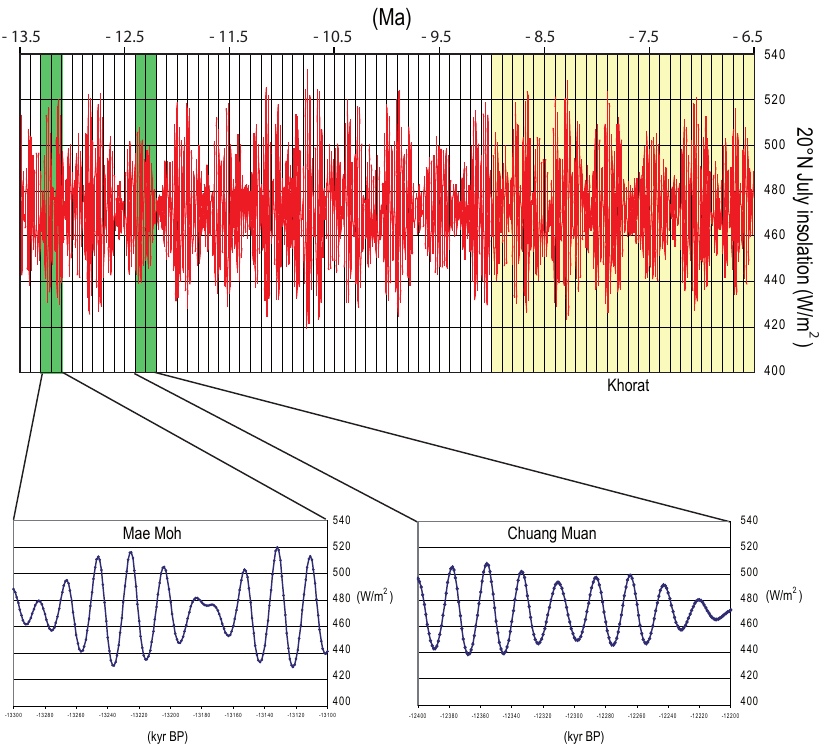
Figure 4. Northern hemisphere summer insolation computed at 20°N, between 13.5 and 6.5 Ma, from La2004 numerical solutions. Bottom panel indicates values over the Mae Moh and Chiang Muan record intervals. Color-bars indicate estimated time range of the Miocene pollen records.